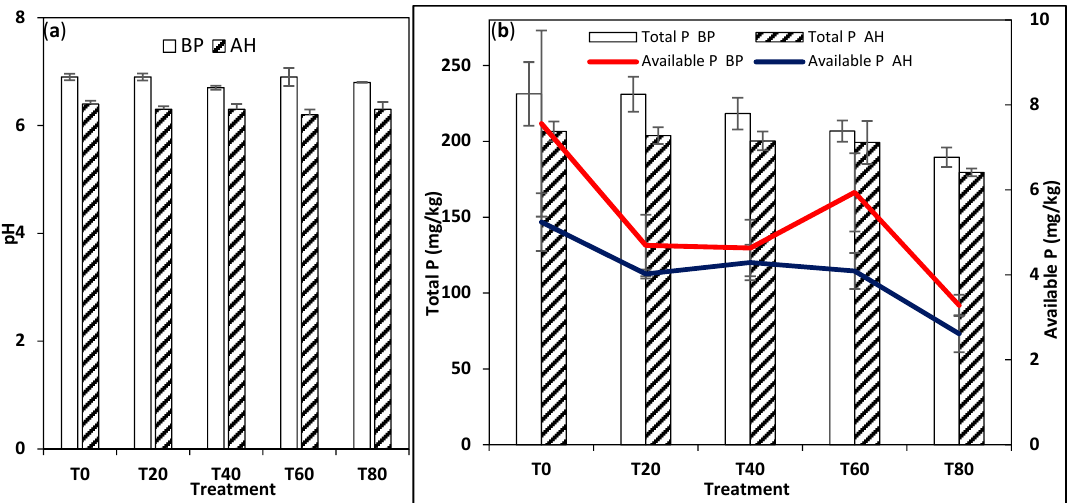
Figure 5. Effects of fertilizer treatments on ( a ) pH and ( b ) total P and available P measured before planting (BP) and after harvest (AH) of Amaranthus cruentus cultivated on dry savanna soils.